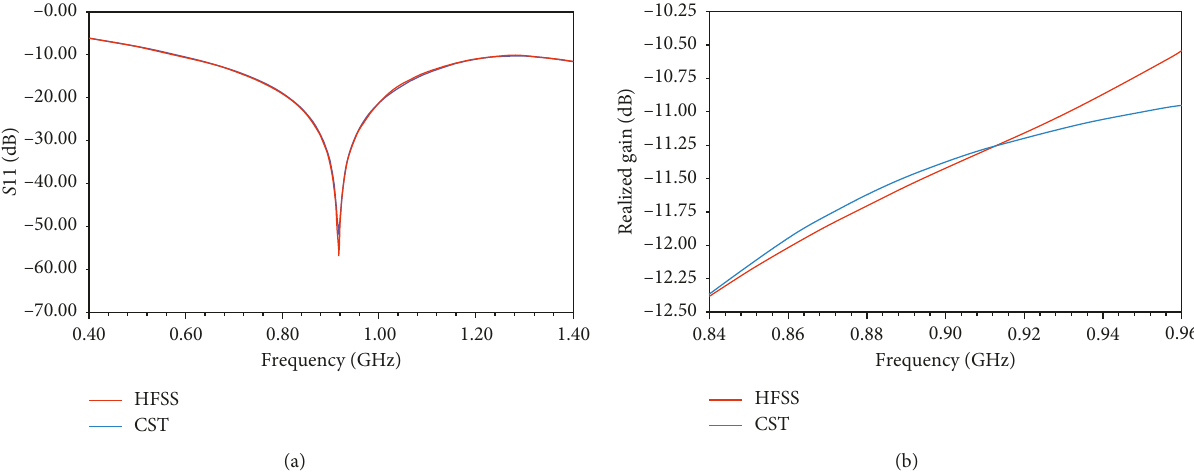
Figure 9: Comparison of the S 11 results (a) and realized gain (b) of the first proposed antenna between the two simulators HFSS and CST.